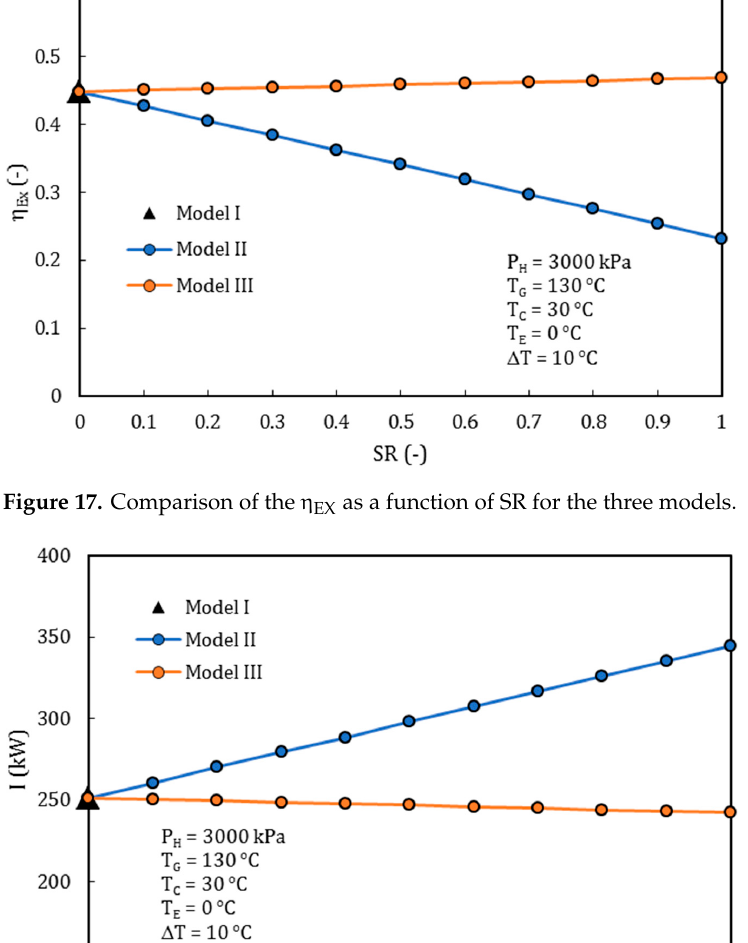
Figure 18. Comparison of the I as a function of SR for the three models.